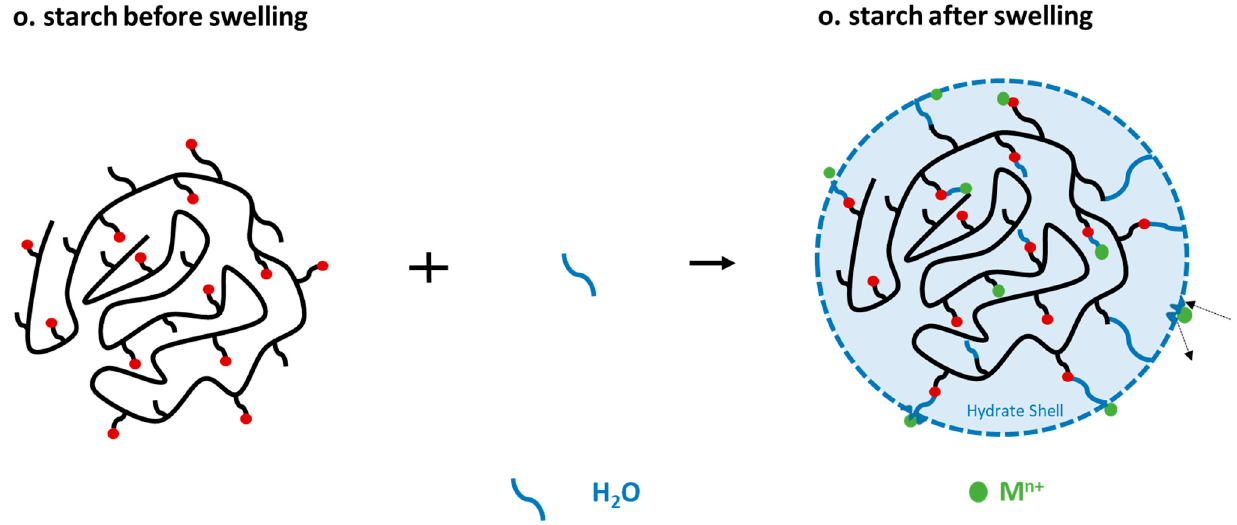
Figure 9. Formation of the hydrate shell because of swelling of the starch in water.